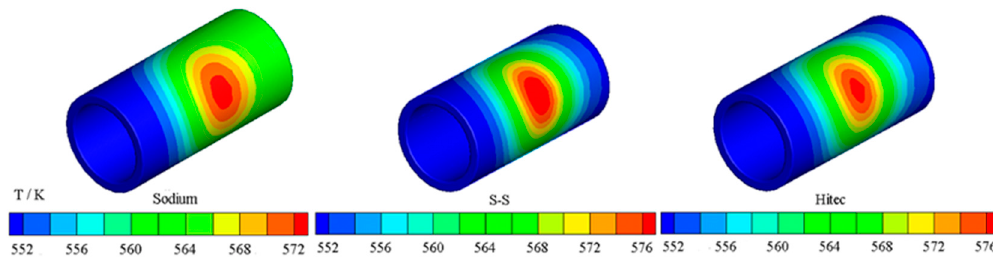
Figure 7. Temperature distribution on tube wall of sodium, S-S, and Hitec.